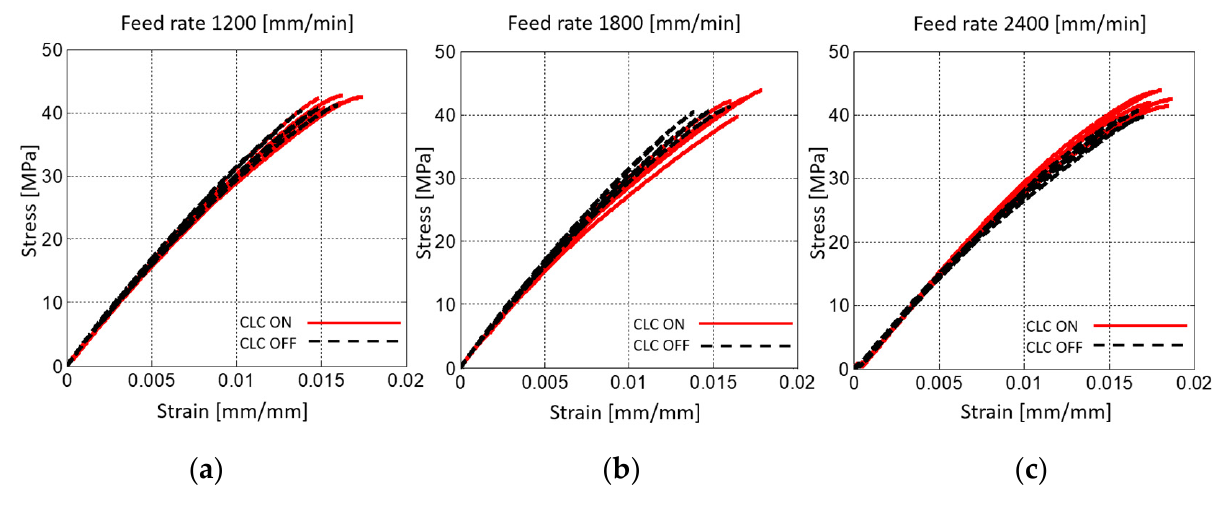
Figure 6. Stress–strain plots for S TR samples fabricated with ( a ) F = 1200 mm/min, ( b ) F = 1800 mm/min and ( c ) F = 2400 mm/min. Black dashed lines and continuous red lines represent samples fabricated with disabled CLC and enabled CLC, respectively.